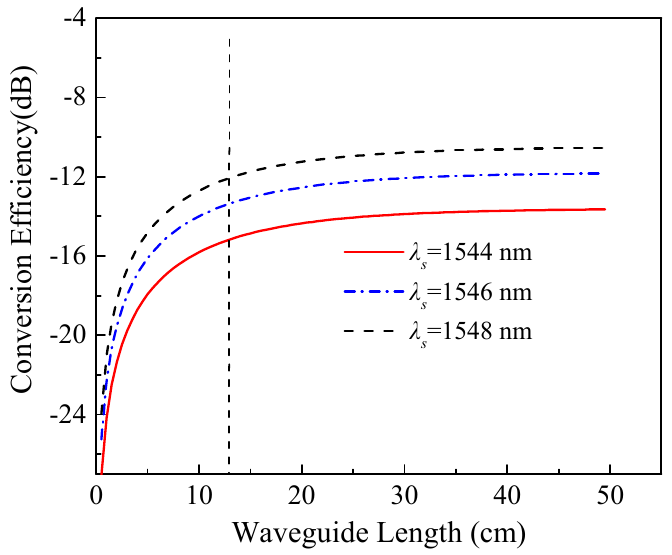
Figure 9. The calculated conversion efficiency of the FWM process of the PECVD silicon nitride waveguide. Here, the pump power and pump wavelength are 0.5 W and 1550 nm, respectively.